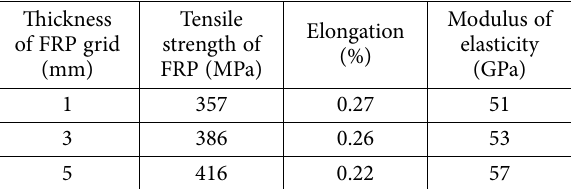
Table 3. Different factors of the experimental RC beams Bond length Number of CRL